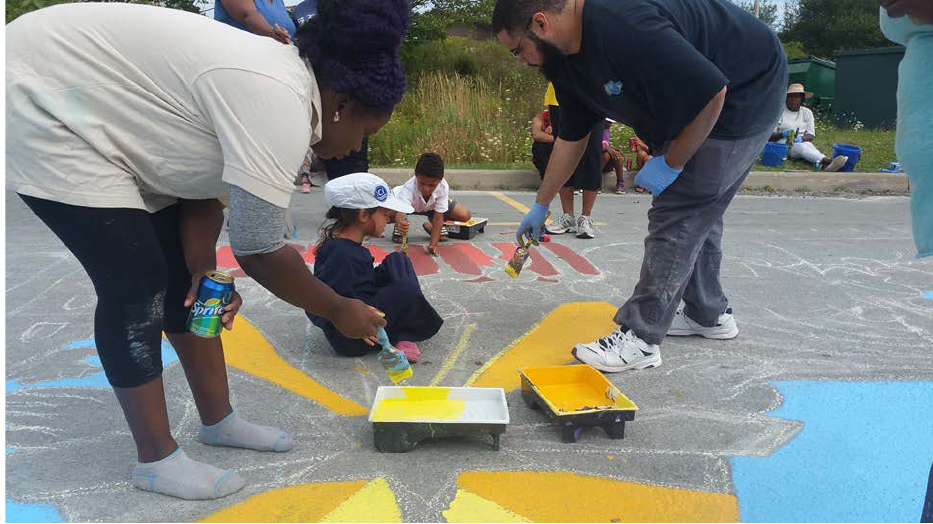
Figure 8. Community activity on parking lot asphalt. Photo from Preston Facebook Page.